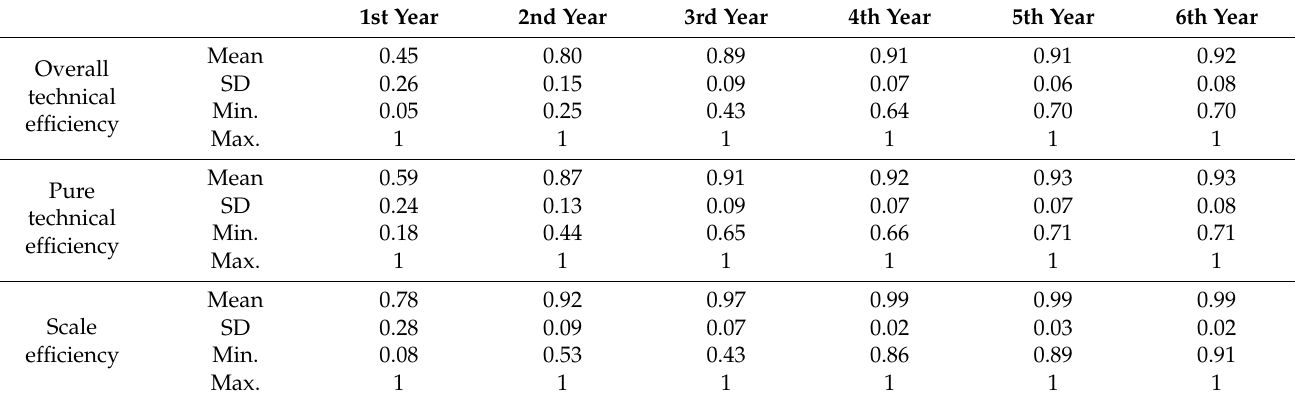
Table 4. Descriptive statistics of efficiency scores in the first six years.